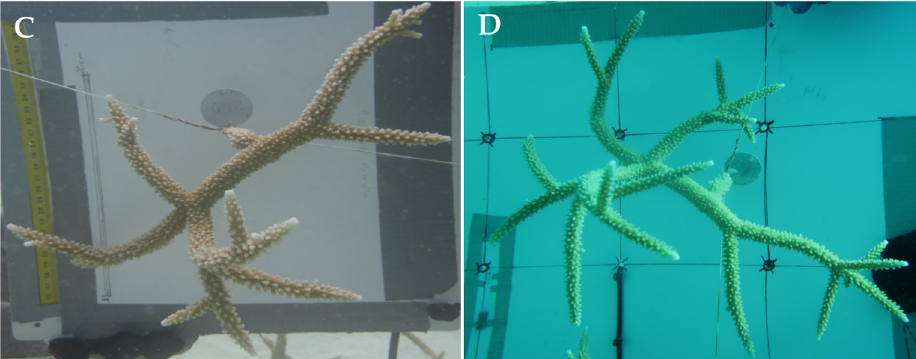
Figure 4. Clone fragment number 250 followed through time. Image of clone fragment 250 before hanged on farm in June 2016 ( A ), and image showing the same coral in December 2016 ( B ), March 2017 ( C ) and June 2017 ( D ).